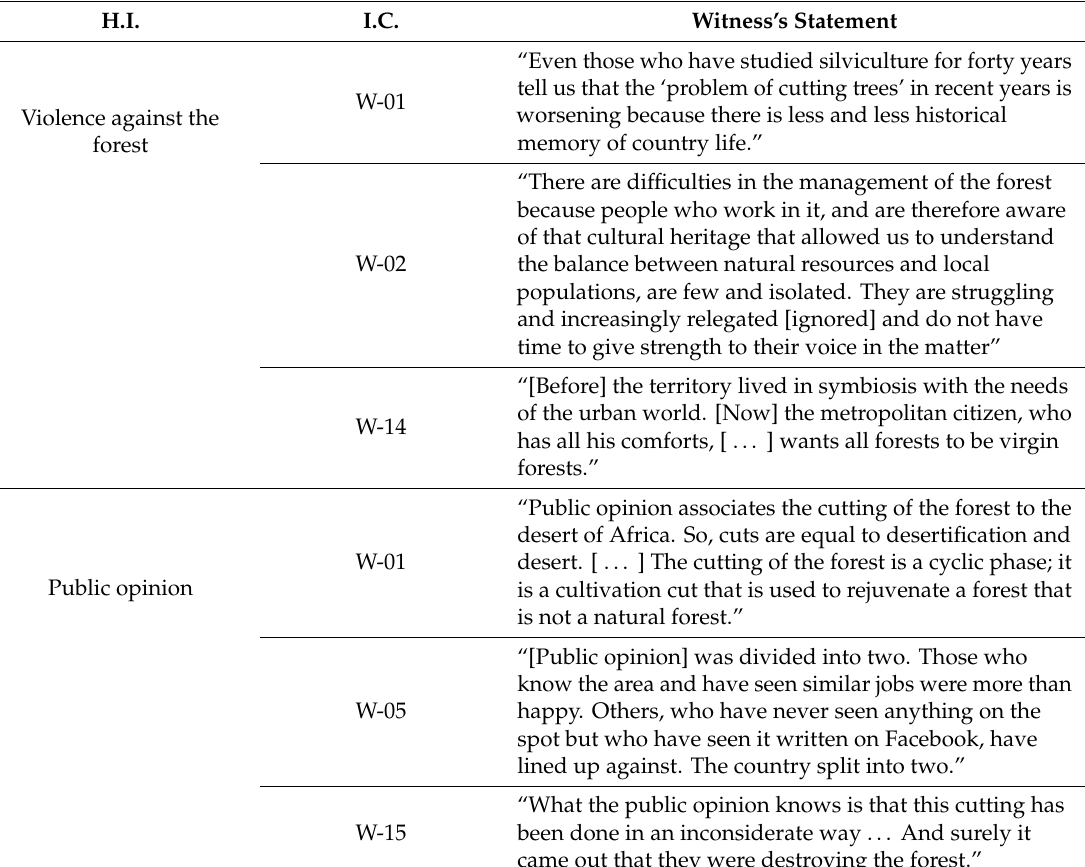
Table 6. Homogeneous information (H.I.) about the perception of silvicultural activities.